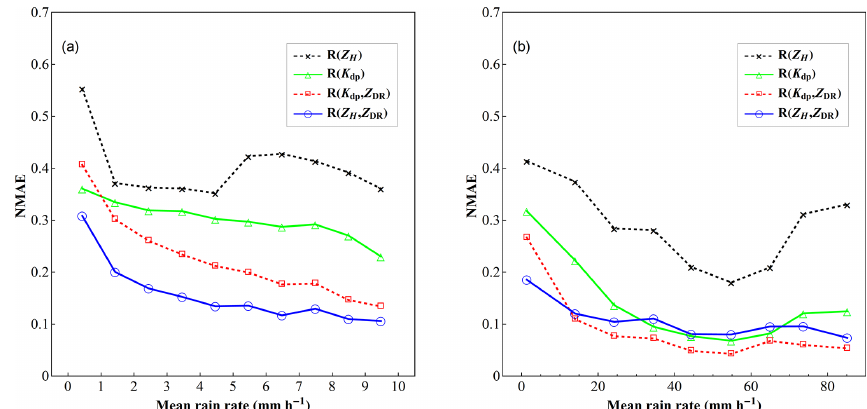
Figure 15. Parameterization error structure of R(Z H ) , R(K dp ) , R(K dp , Z DR ) , and R(Z H , Z DR ) as a function of rainfall rate: (a) for mean rain rate less than 10mmh − 1 ; (b) for rain rate of the whole